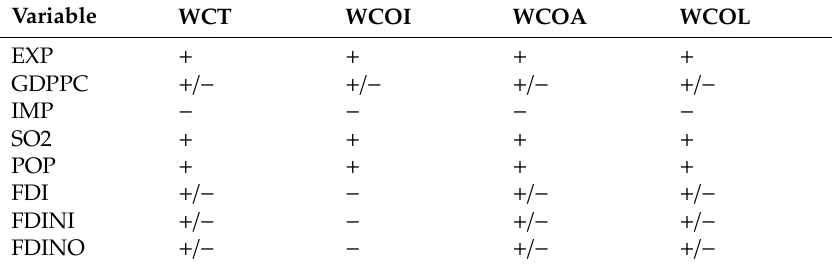
Table 4. The expected signs of the coe ffi cients of the di ff erent independent